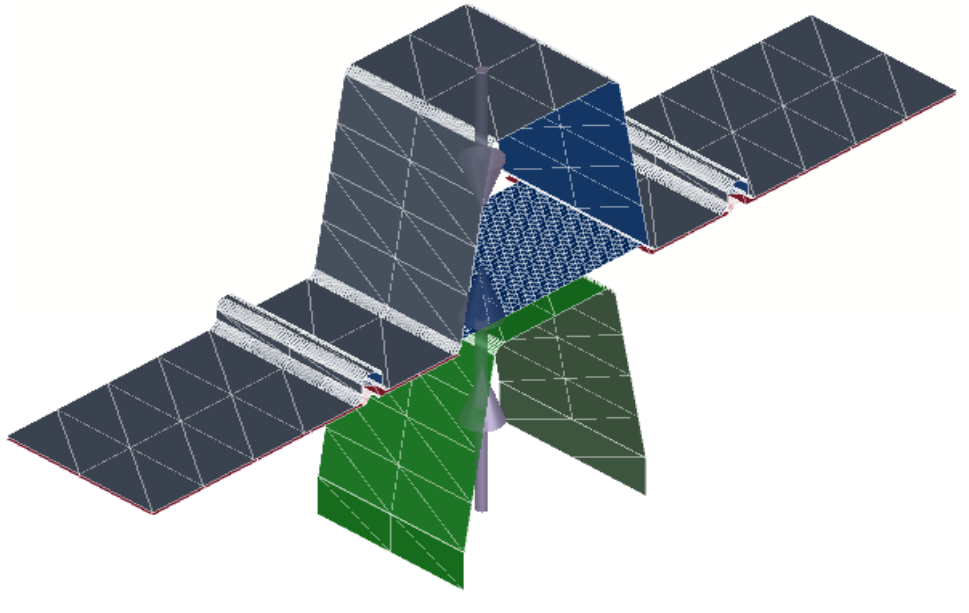
Figure 12. Finite element model.